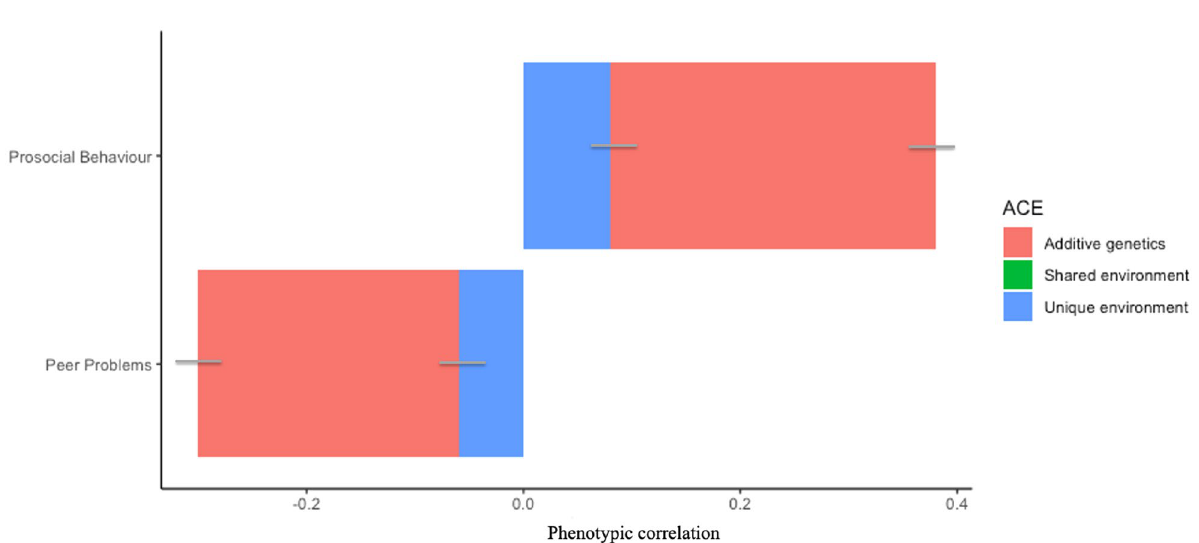
Figure 4. Genetic and environmental contribution to phenotypic associations between general media use and mental health. Note : Bars represent 95% confidence intervals around estimates. Prosocial Behaviour = prosocial behaviour score derived from the subscale of the Strength and Difficulties Questionnaire (SDQ) 39 , Peer Problems = total peer problems score derived from the subscale of the SDQ 39